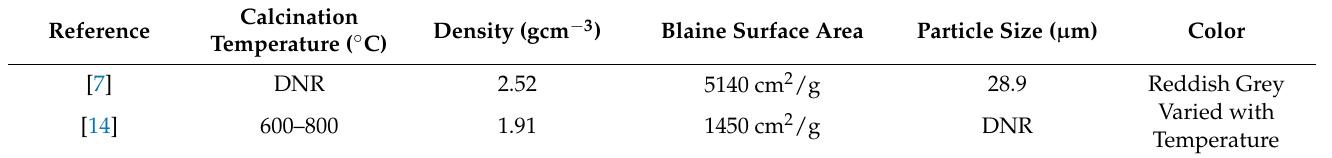
Table 1. Physical properties of